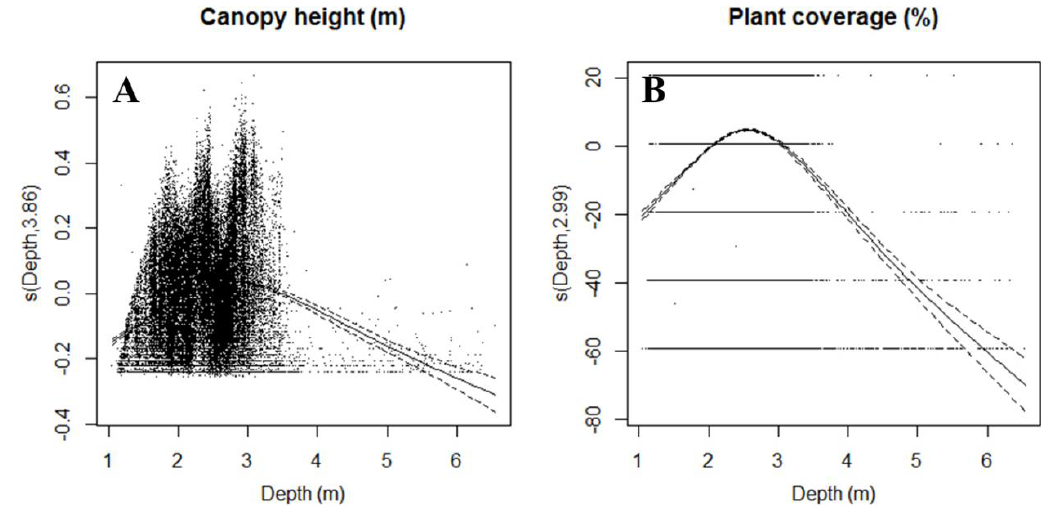
Figure 6. Response curves (thick, solid lines) of Zostera marina L. canopy height ( A ) and coverage ( B ) to water depth. Fitted model plots for depth corresponding to the reduced GAM for canopy height (m) and plant coverage (%). The solid lines show the GAM regressions fitted to each relationship, with dotted lines indicating the confidence interval of the mean trend line.